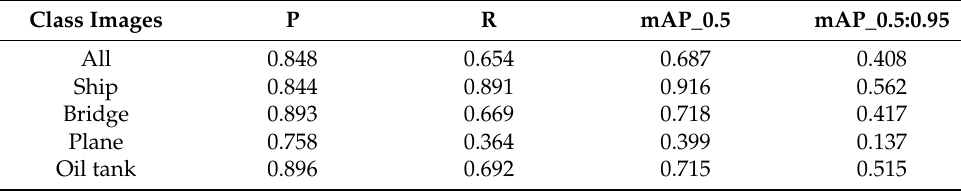
Figure 11. Comparison of yolov5 with and without proposed SR processing. The zoomed gray box is illustrated on the right diagram. The orange line and the cyan line are the fitted curves of the points. Table 5. Results of yolov5 in MSAR